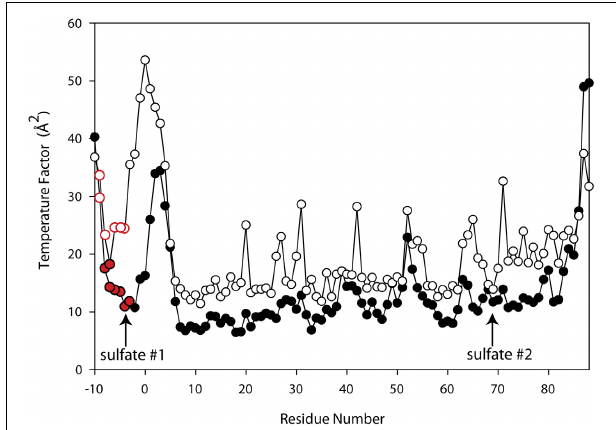
FIGURE 5 | Superimposed Temperature Factor plot of wild-type glutaredoxin (solid circles) (3QMX) vs. A75I (white circles). The red color depicts the His-residues that make up the His-tag of the molecule. The arrows show the location of the shortest sulfate:amino acid